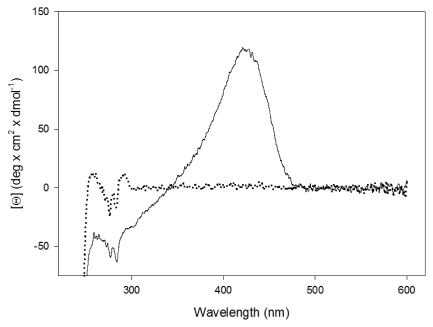
CD spectra of holo-piSHMT (continuous line) and apo-piSHMT (dotted line). CD spectra were recorded on 30 μM enzyme samples at 20 °C, in 20 mM potassium phosphate pH 7.2, containing 0.2 mM DTT, 0.1 mM EDTA and 50 mM Na2SO4.